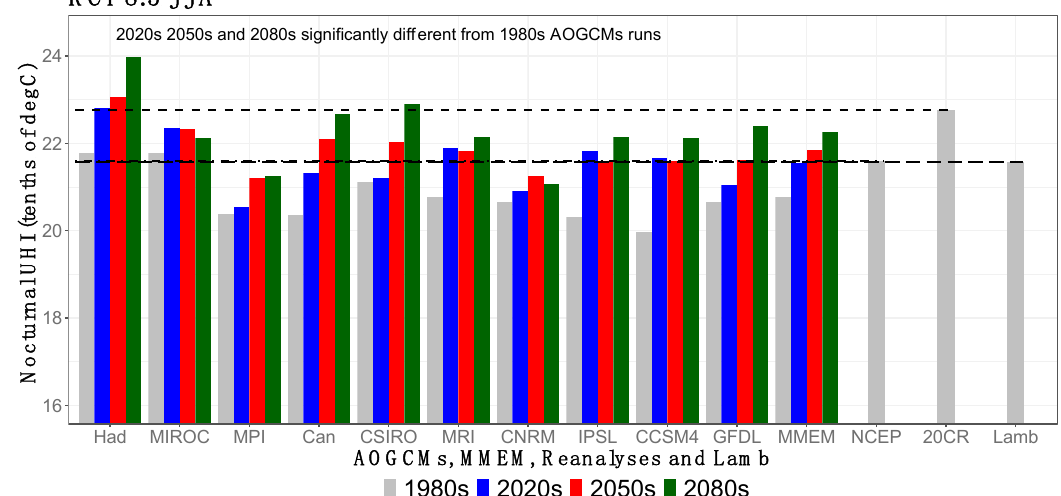
Figure 7. As per Figure 6 but for London’s nocturnal Urban Heat Island (UHI) in tenths of degree Celsius (°C) during summer (JJA).